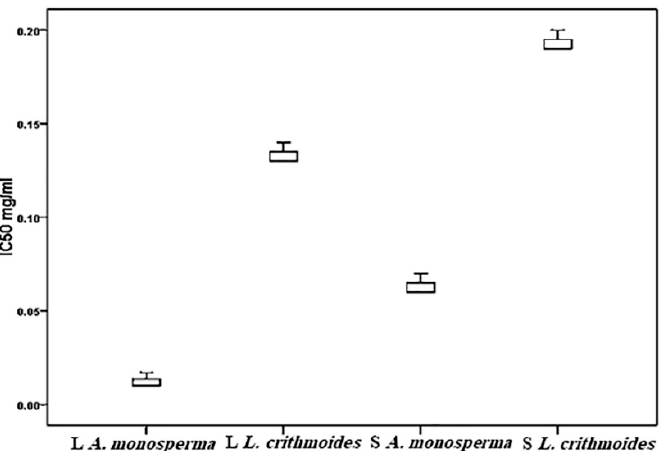
Figure 6. DPPH (1,1-diphenyl-2-picrylhydrazyl) radical scavenging capacity (IC50) in the leaf (L) and stem (S) of A. monosperma and L. crithmoides . Mean values are significantly different at p < 0.05.